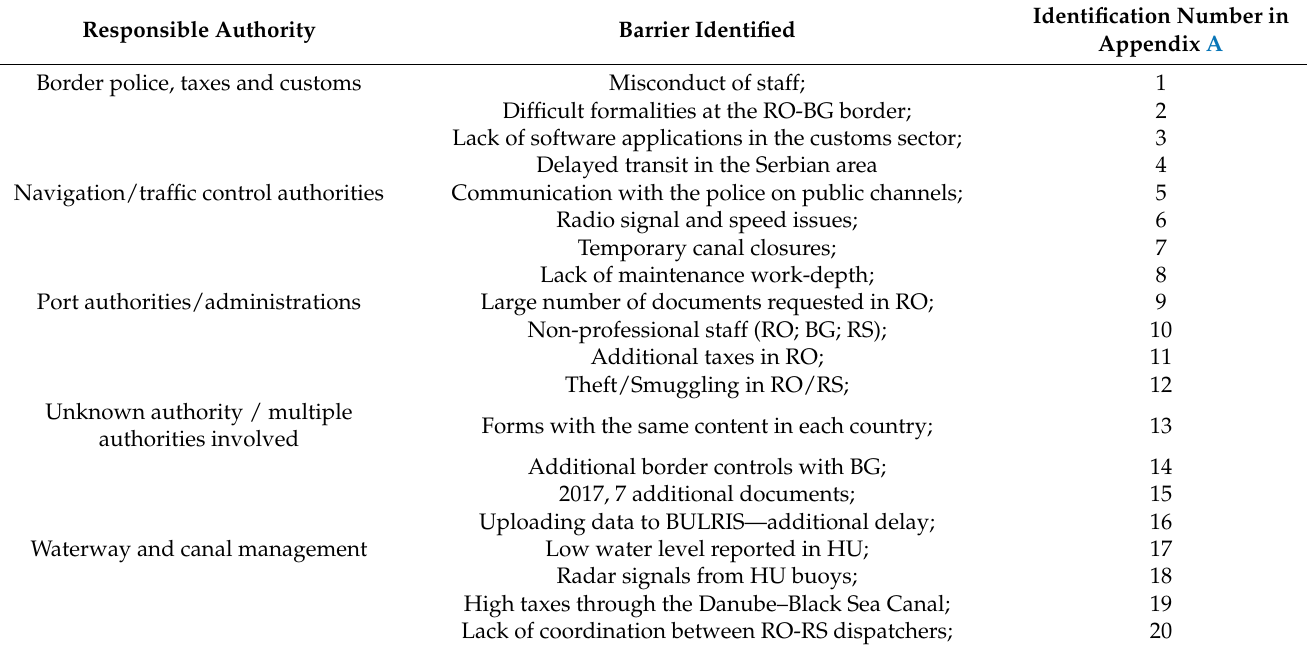
Table 1. Presentation of the main administrative barriers and competent